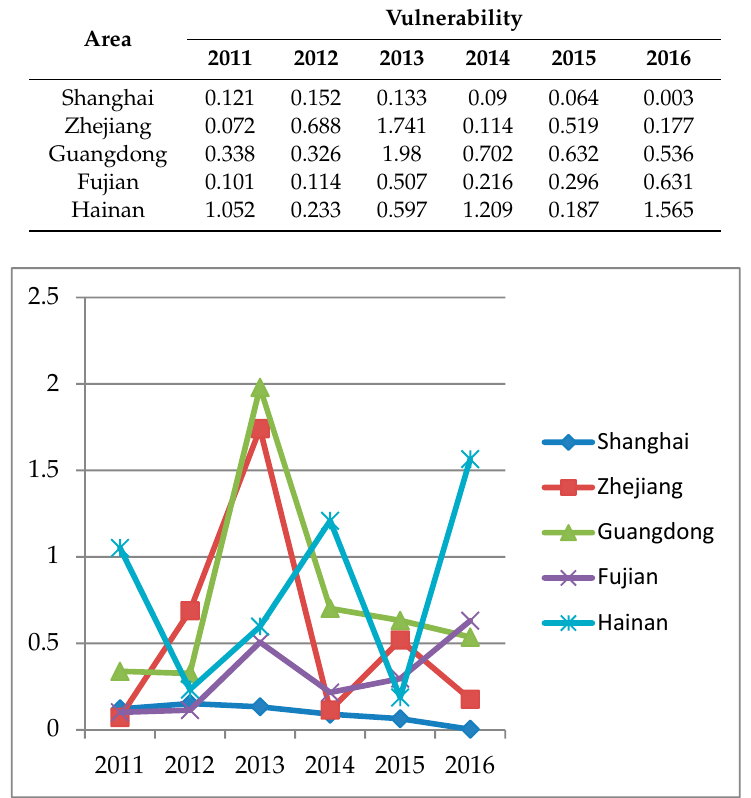
Figure 2. The change of vulnerability to typhoon.